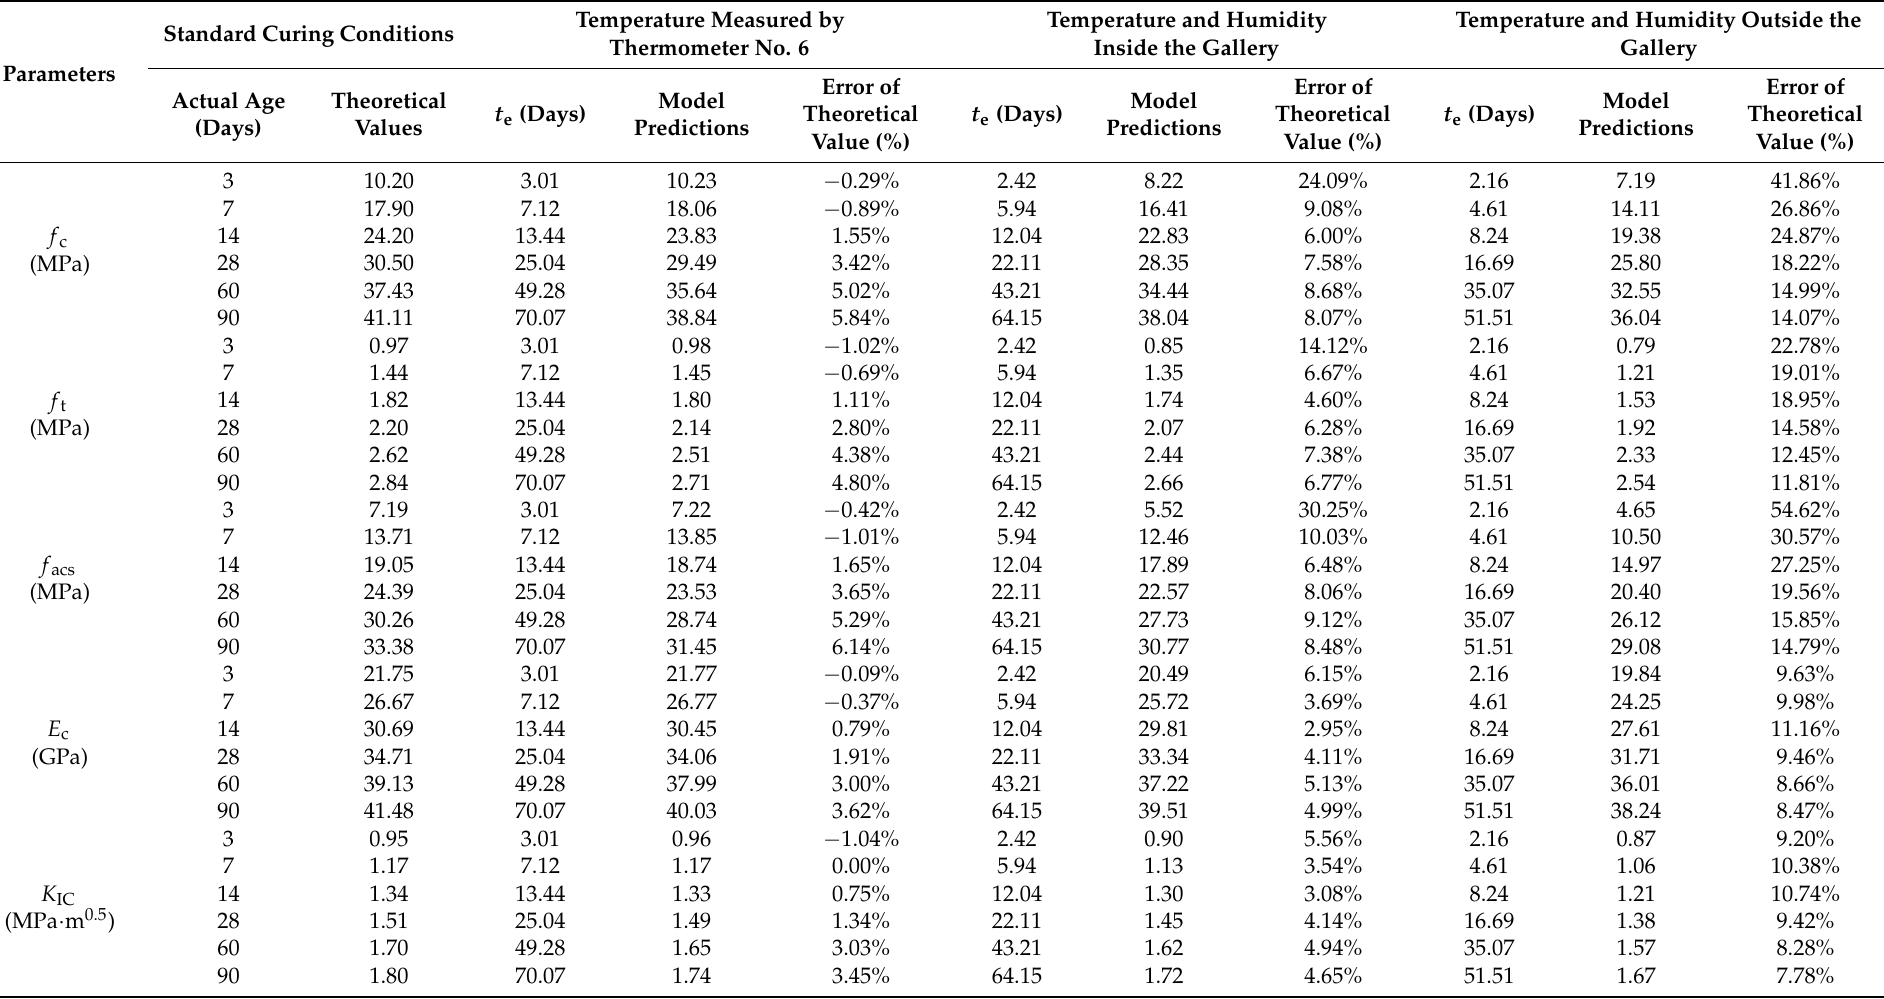
Table 8. Comparison between concrete strength and fracture parameters given by prediction model and traditional